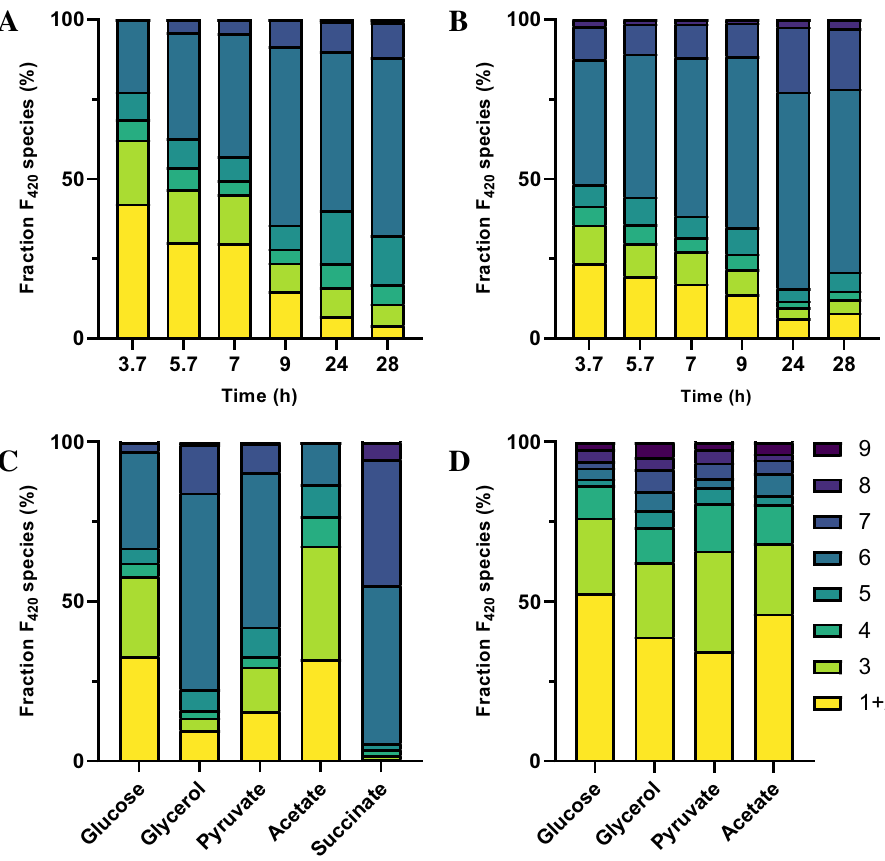
Figure 8. HPLC-FLD data for different glutamate residues attached to F 420 at different time points after induction of F 420 pathway using Glucose ( A ) and Glycerol ( B ). HPLC-FLD data for different glutamate residues attached to F 420 ( C ) and 3PG -F 420 ( D ) using different carbon sources at the end of exponential phase.